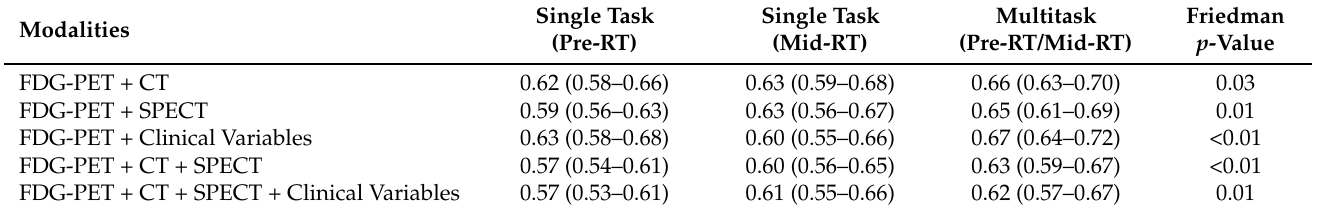
Table 3. Prediction performance of overall survival in terms of c-index for the proposed model of a single time point or multiple time points for the combination of modalities. Here, FLSGL was applied on each modality at single-/multi-time points separately and results (each row) were ensembled using CWGBS at single-/multi-time points for different multimodality combinations. p -values of the Friedman ANOVA test are reported for each modality combination between multitask and single-task learning time points.